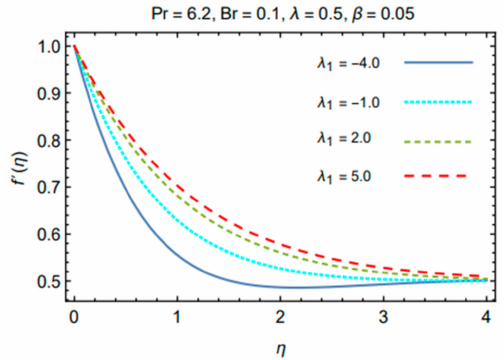
Figure 2. Variation in f (cid:48) ( η ) against λ 1